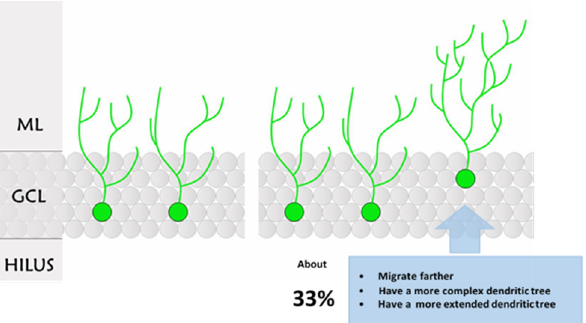
Figure 10. Summary representation of the differences between CTRL and RUN 30-day-old GFP- positive granule cells. In the figure are outlined the features of newly generated granule cells at 30 days after GFP injection in CTRL vs. RUN groups. ML: molecular layer; GCL: granule cell layer.